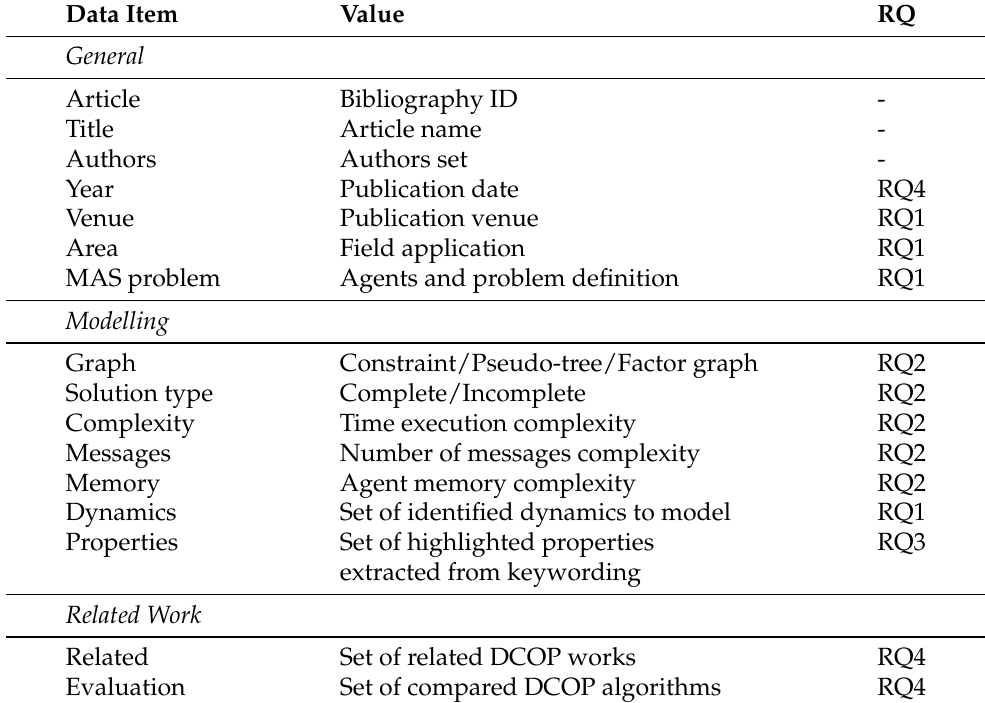
Table 4. Data extraction